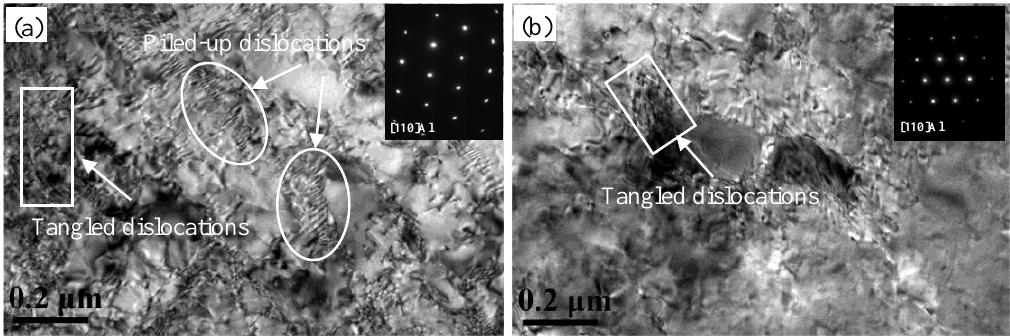
Figure 6. TEM images of ( a ) annealed and ( b ) quenched 5083 alloy sheets after tensile deformation.